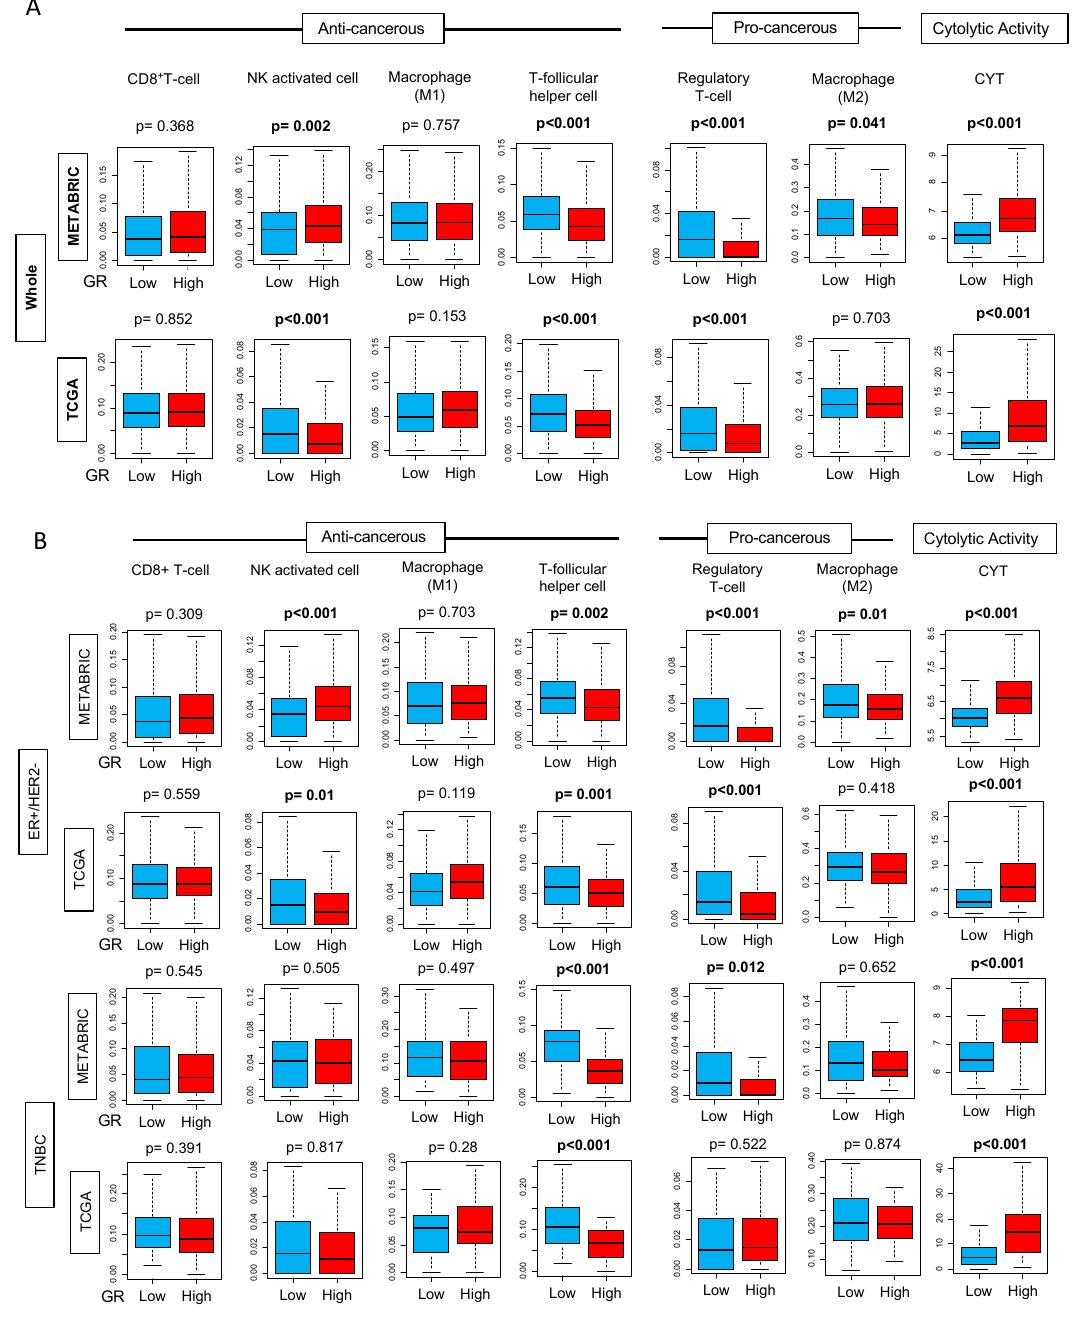
Figure 4. Tukey boxplots of immune cells CD8 + T-cells, Natural Killer (NK) activated cells, M1 and M2 macrophages, T-follicular helper cells, T-regulatory cells, and cytolytic activity (CYT) in GR-high and GR-low breast cancer using CIBERSORT algorithm in METABRIC and TCGA cohorts ( A ) in the entire cohort (Whole) and ( B ) in estrogen receptor (ER)-positive/human epidermal growth factor receptor (HER2)-negative and triple negative (TNBC) subtypes. The cut-off of top and bottom quartile of NR3C1 expression was considered as GR high and GR low in the entire cohort and also in the respective subtypes. Y -axis shows the fraction of cells with GR-low or GR-high expression. Boxes depict medians and interquartile ranges. Depicted p values are calculated using one-way ANOVA.